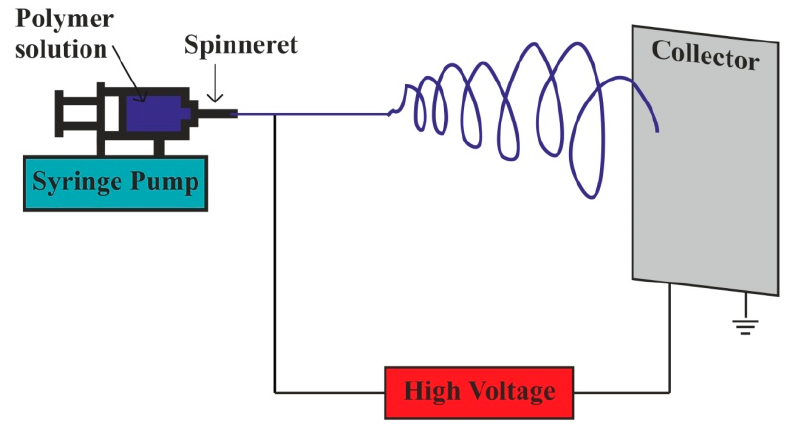
Figure 11. Electrospinning process.